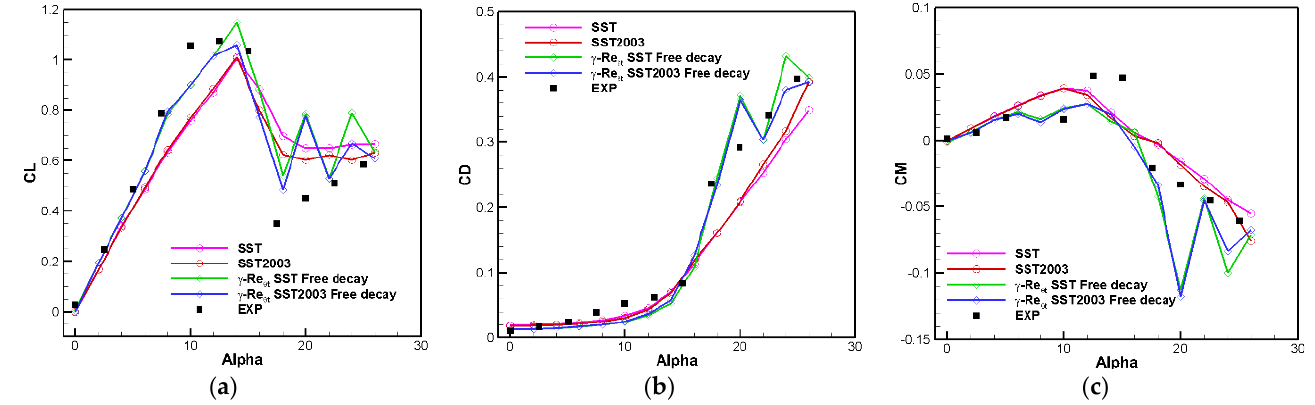
Figure 4. Computed force coefficients predicted by different approaches versus experimental data. ( a ) Lift coefficient vs. AoA. ( b ) D rag coefficient vs. AoA. ( c ) Pitching moment coefficient vs. AoA.